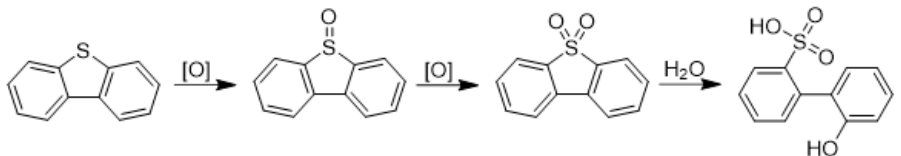
Figure 5. Oxidation of two representative structures within petcoke with nitric acid (adapted with permission from ref [47]; published by Elsevier, 1994).